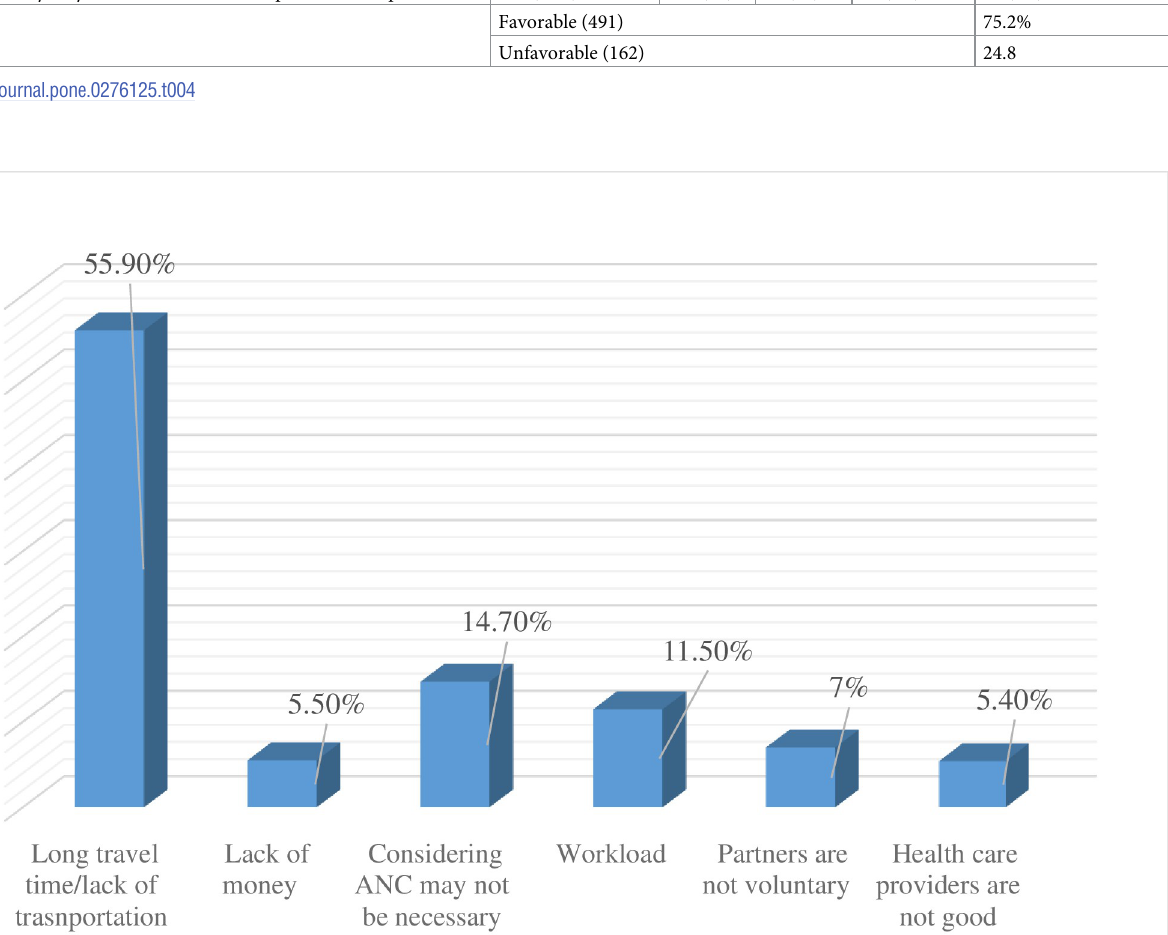
PLOS ONE | https://doi.org/10.1371/journal.pone.0276125 October 12,